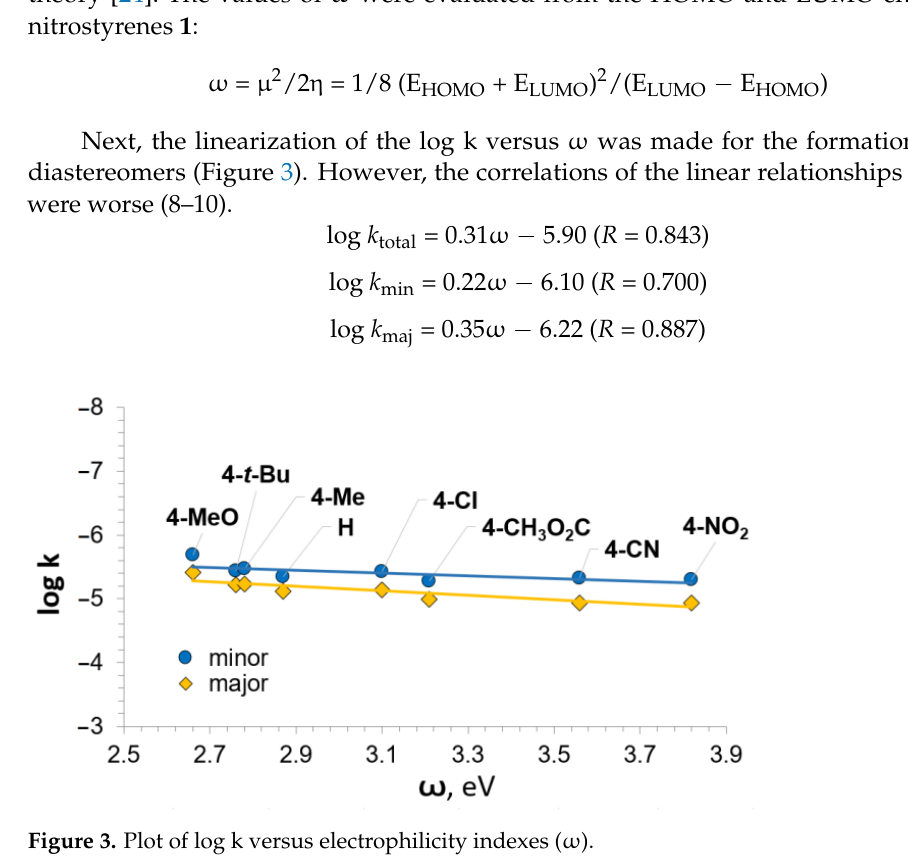
Table 3. Kinetic data of the reactions of β-substituted nitrostyrenes with pyrrole. Substrate β-Substituent